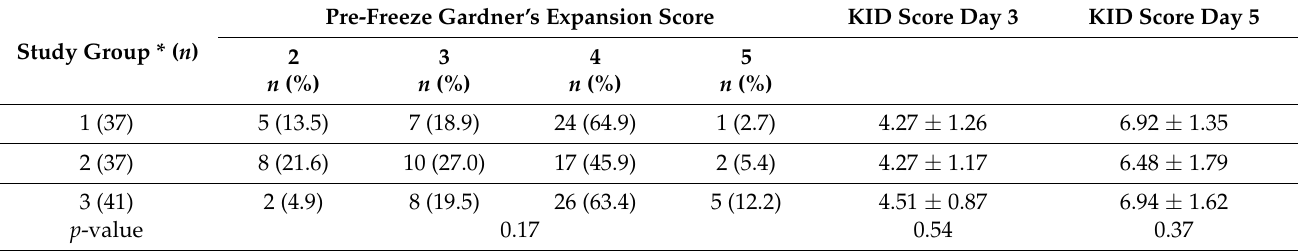
Figure 3. Histogram illustrating changes in size between the two-hour diameter and immediate post-thaw diameter for each of 115 embryos ( µ m). Table 1. Pre-vitrification embryonic data as expressed by expansion score and KID score.